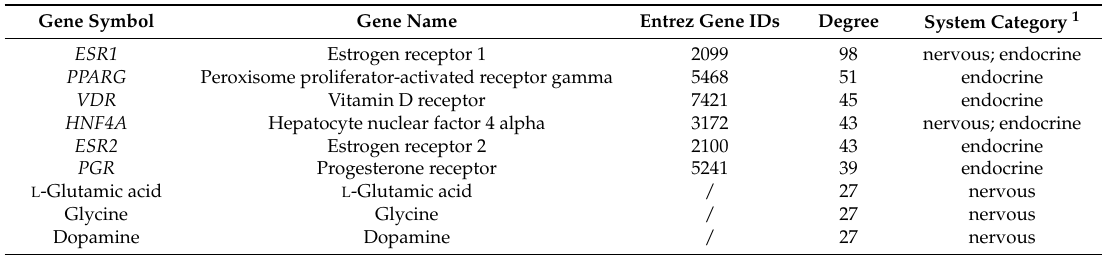
Table 1. The top 10 signaling molecules in the core